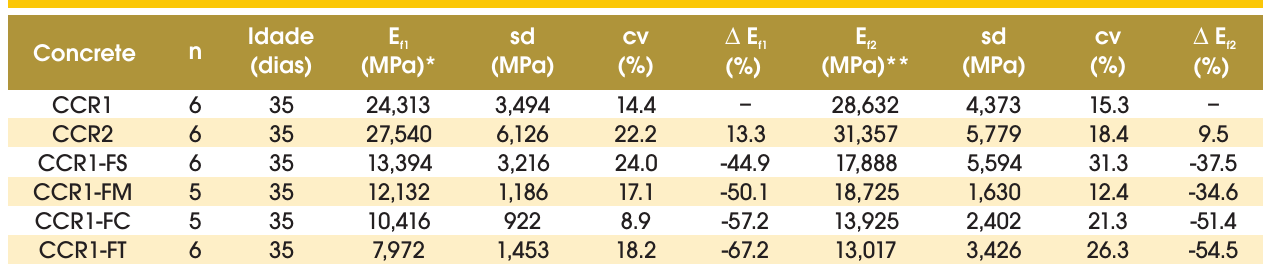
Table 8 – Flexural modulus of elasticity of RCC.